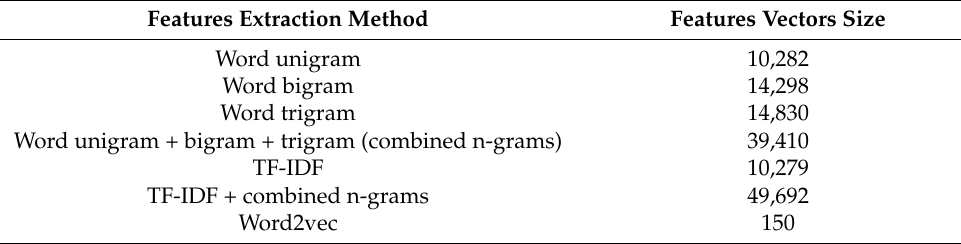
Table 6. Results of the extracted features vector